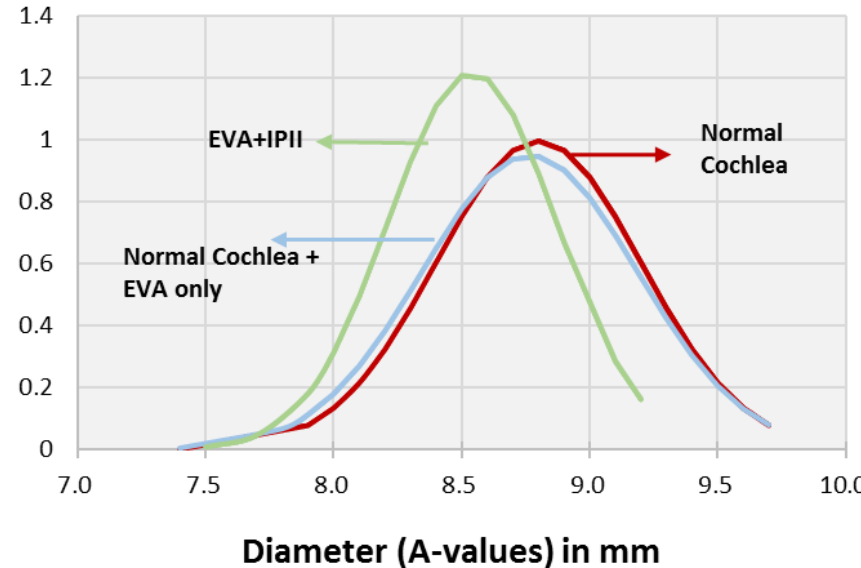
Figure 2. Bell curve (normal distribution curve) of the A value comparing the groups with normal cochleae, normal cochleae + EVA only, and EVA + IP II.